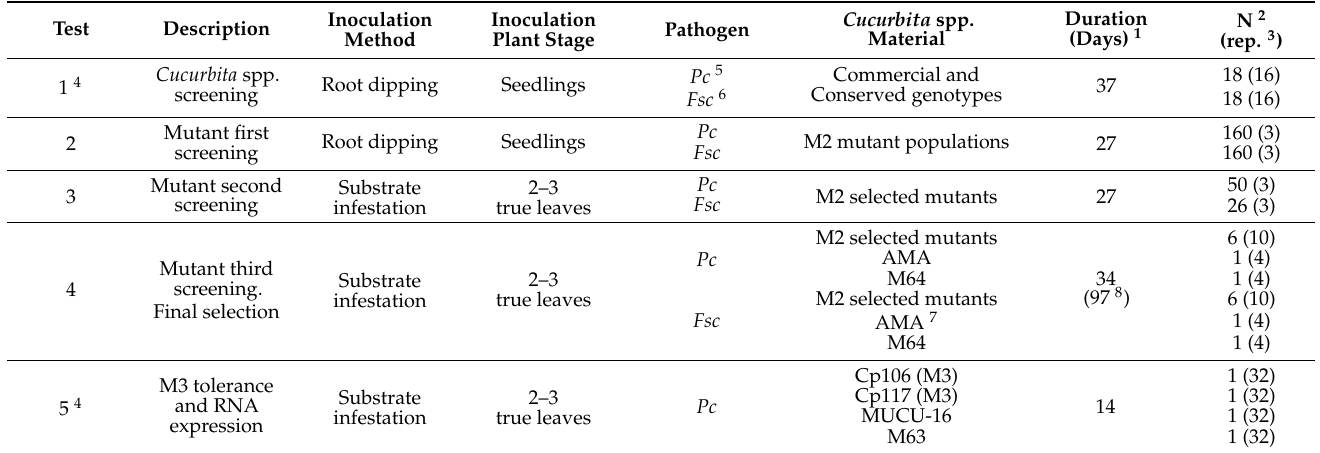
Table 1. Summary of the inoculation tests in chronological